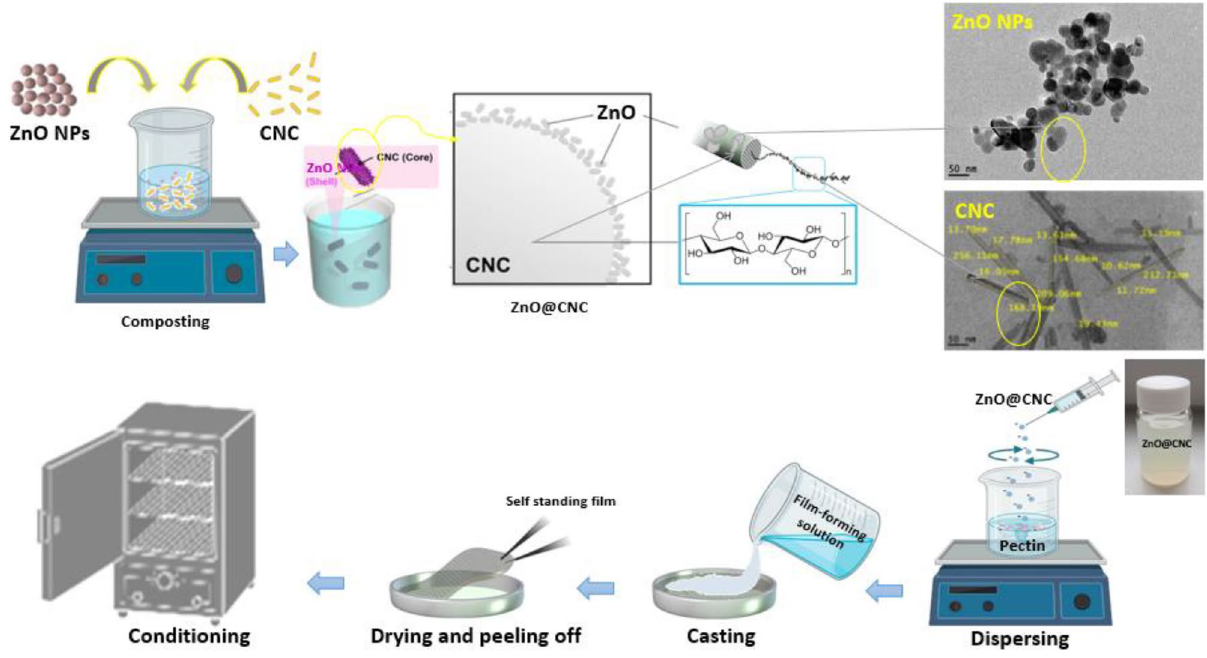
Figure 1. Schematic diagram for the preparation of ZnO/CNC composite and pectin-based nanocomposite